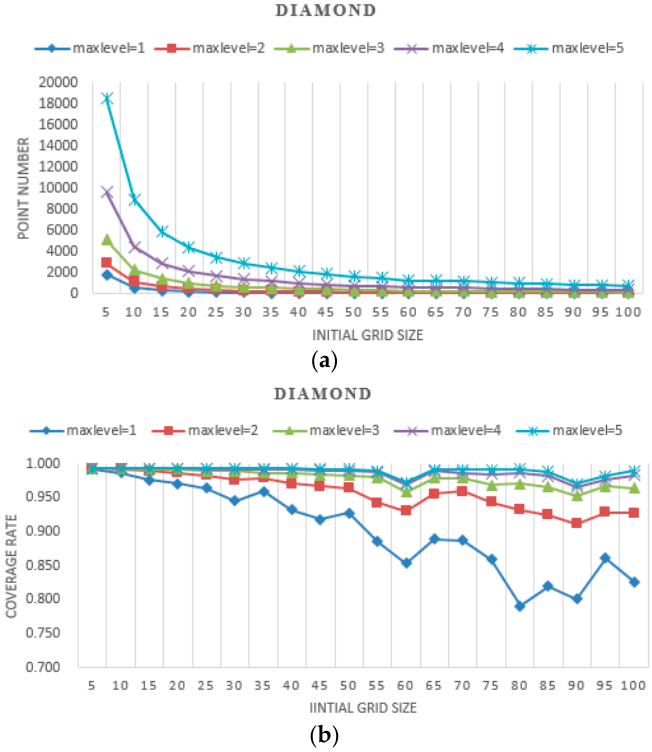
Figure 9. Results for the diamond with different initial grid sizes and max levels. ( a ) point number; ( b ) coverage rate. ISPRS Int. J. Geo-Inf. 2017 , 6 , 110